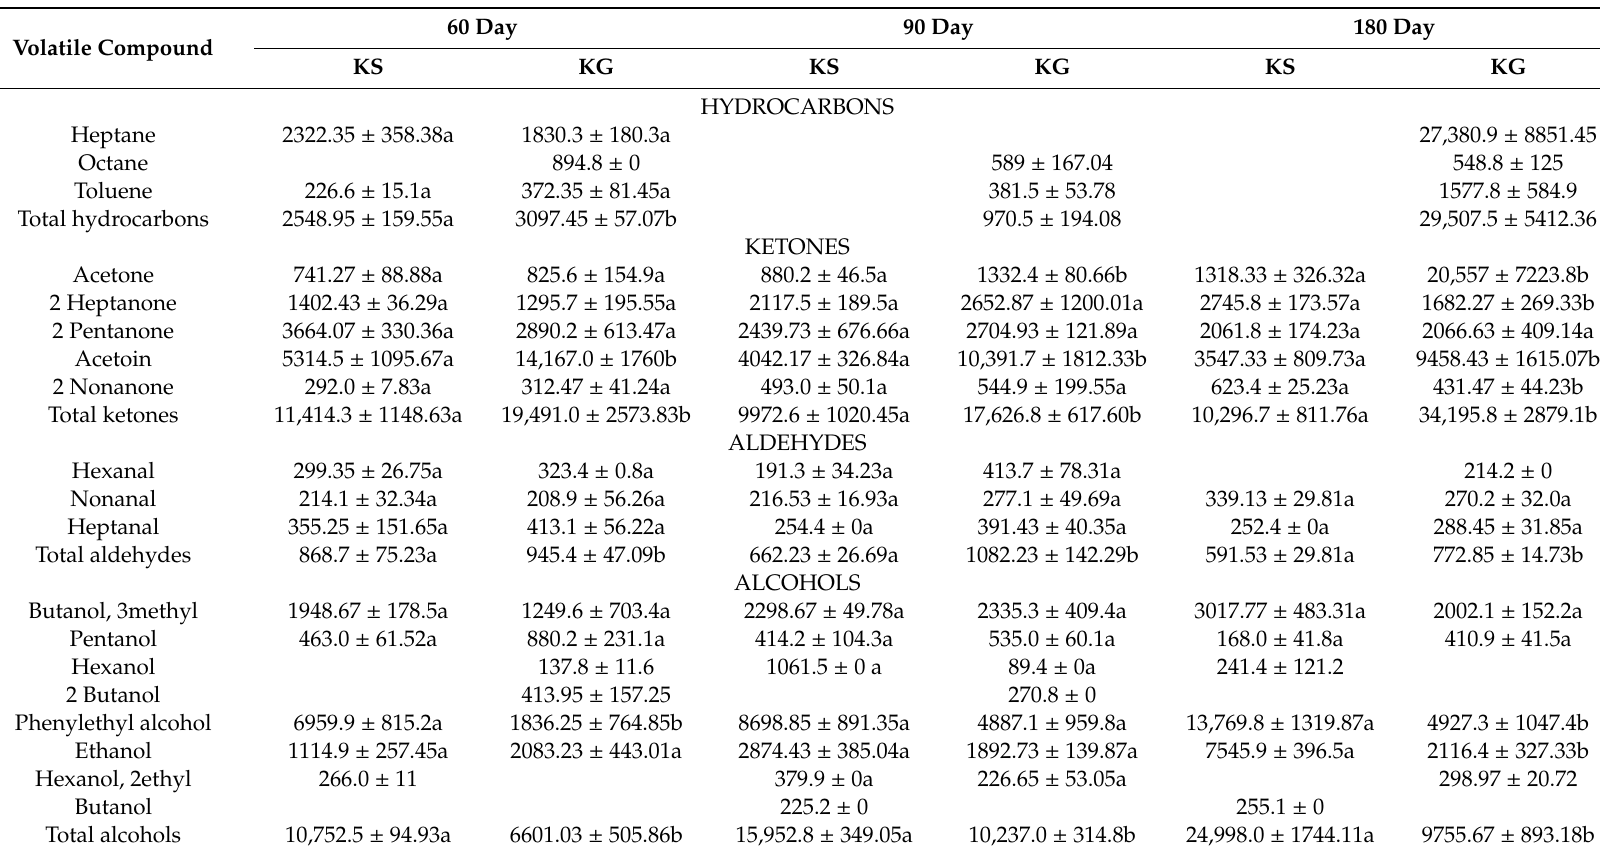
Table 10. Volatile compounds (peak area × 10 3 ) of kashkaval of Pindos cheese made from 100% sheep milk (KS) or a mixture of 90% sheep milk–10% goat (KG) milk during ripening and